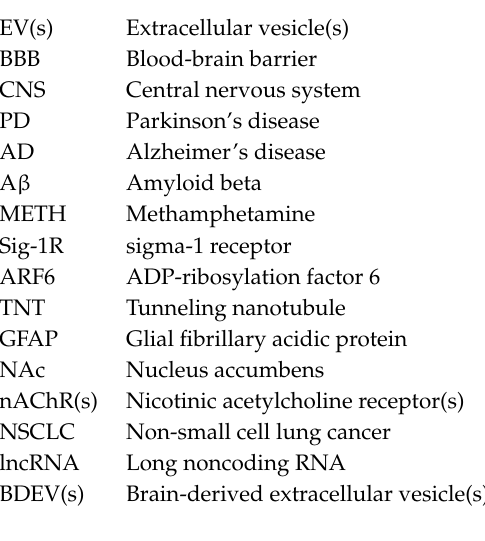
Acknowledgments: Graphical abstract and figure were created using Biorender.com. Conflicts of Interest: The authors declare no conflict of